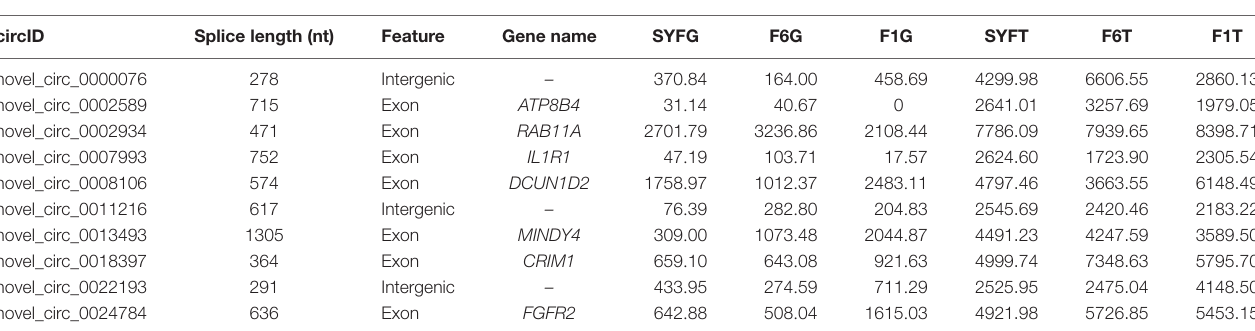
TABLE 3 | Top 10 differentially expressed circRNAs in theca